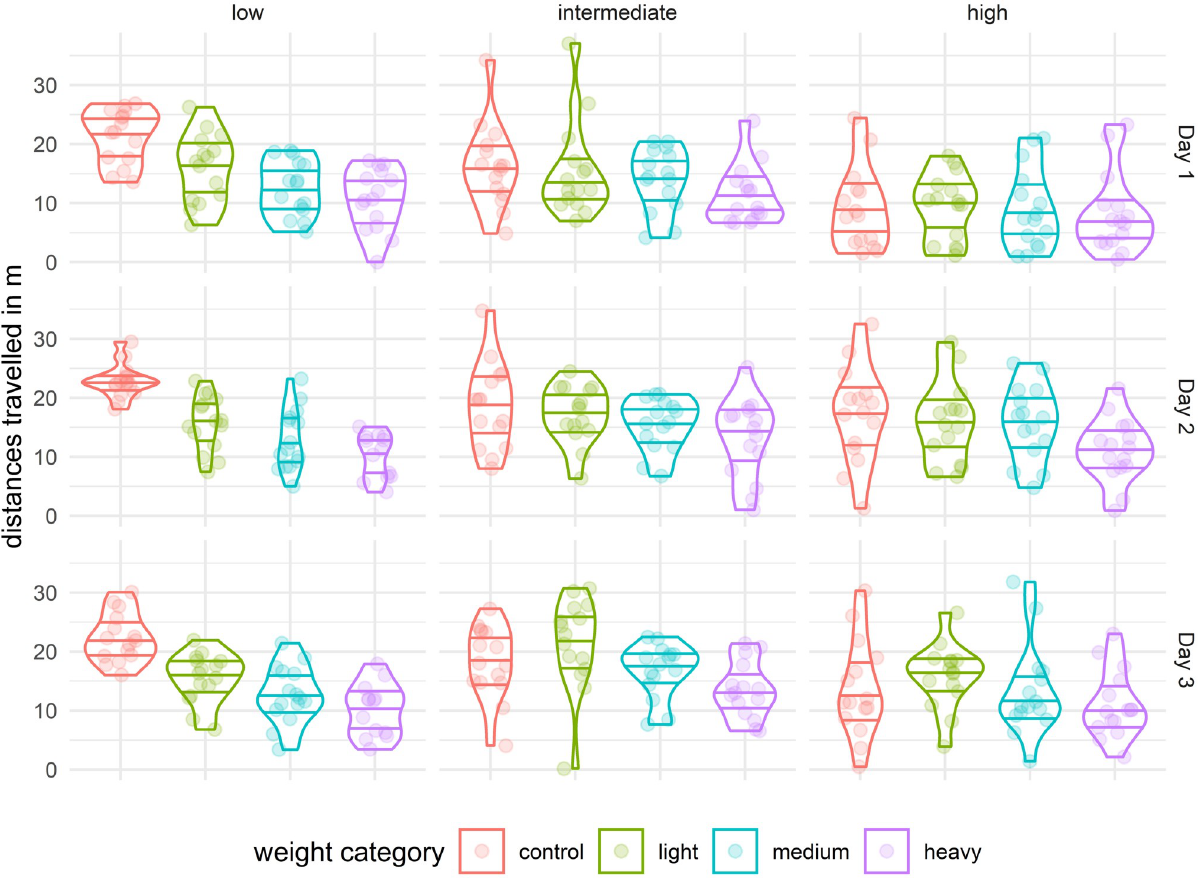
Fig 5. Distributions of distances travelled ( movementSum ) of crickets on all 3 days as affected by low, intermediate, and high temperatures (indicated at the top). The horizontal lines represent, from bottom to top, the 1st quartile, median, and 3rd quartile.